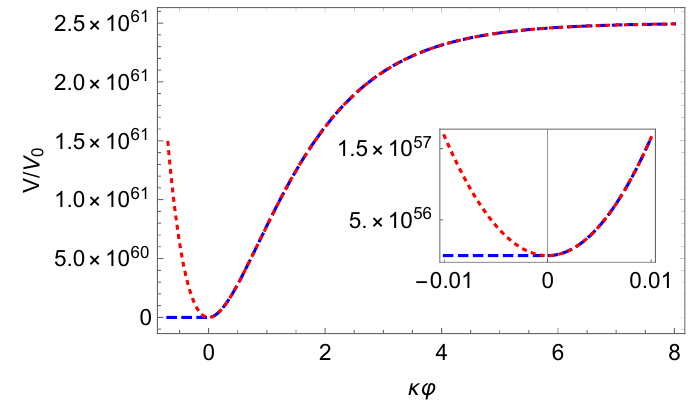
Figure 3 . The comparison of the approximated potential in eq. (3.8) (red dotted line) with the original one in eq. (2.4) (blue dashed line). The potentials without matter contributions ( (cid:24) = 0) are